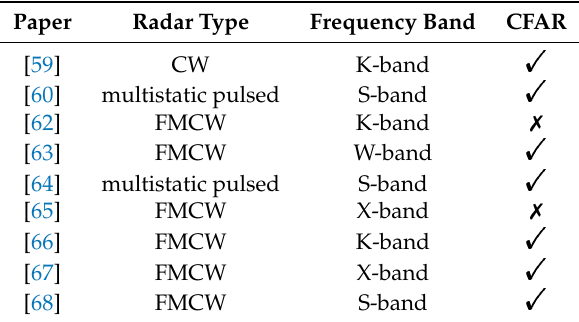
Table 3. Main characteristics of the reviewed drone detection